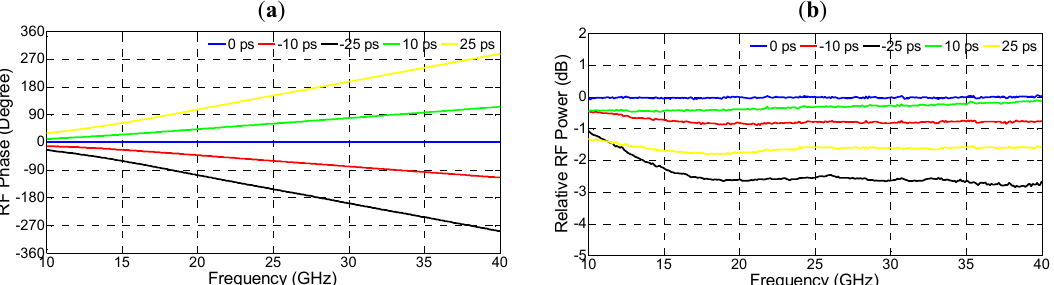
Figure 16. ( a ) The measured phase and ( b ) amplitude response of the new multi-function microwave photonic signal processor designed to realize a tunable true time delay operation.